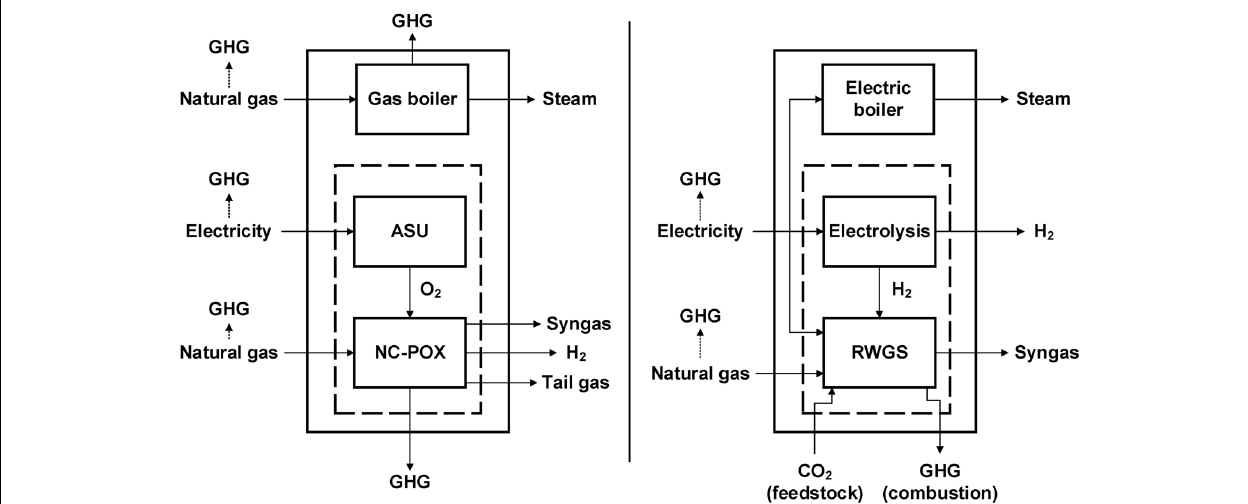
FIGURE 8 | On-site and off-site greenhouse gas (GHG) emissions for the conventional syngas production (left) and the electrified syngas production (right) . The dashed boxes represent the two syngas production technologies. Emissions crossing the solid-lines boxes are on-site emissions while emissions occurring outside of this box are off-site